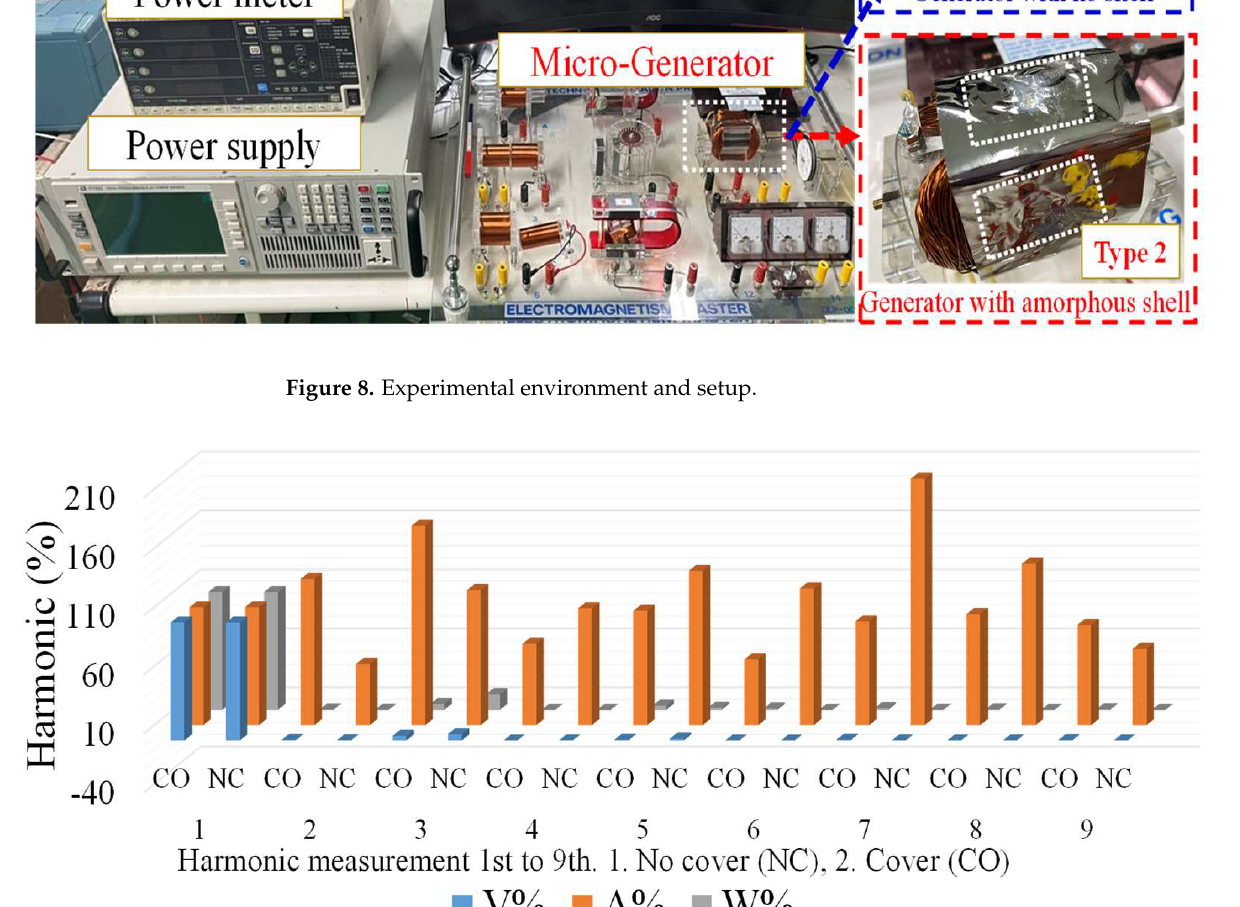
Figure 9. Harmonic performance experiment results of generator with or without amorphous